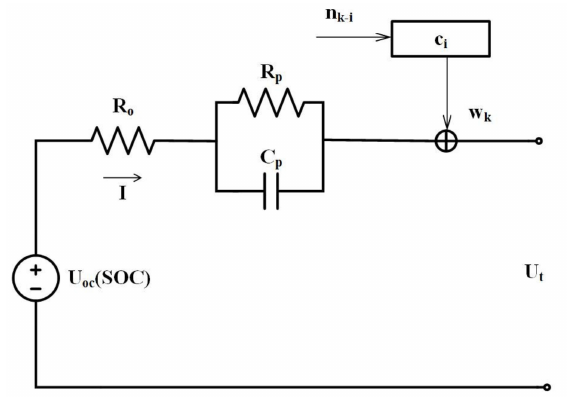
Figure 8. 1-RC model with a moving average noise